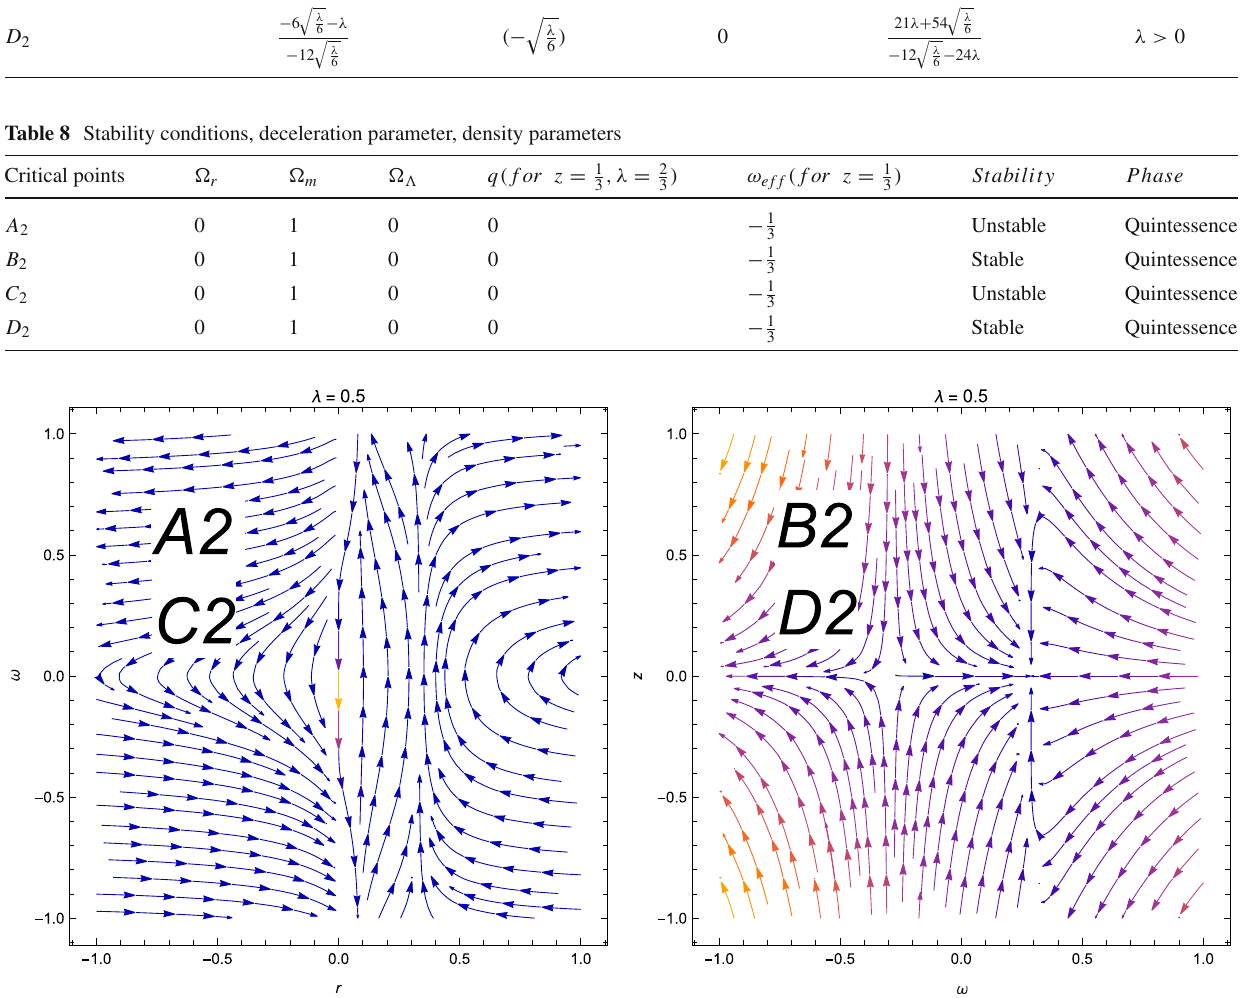
Fig. 4 Phase portrait for mixed power law model for linear interaction. Here we plot the graph between r and w and z and w